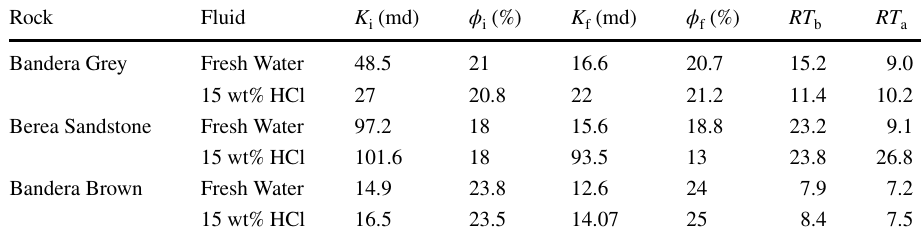
Table 2 Rock properties before and after damage